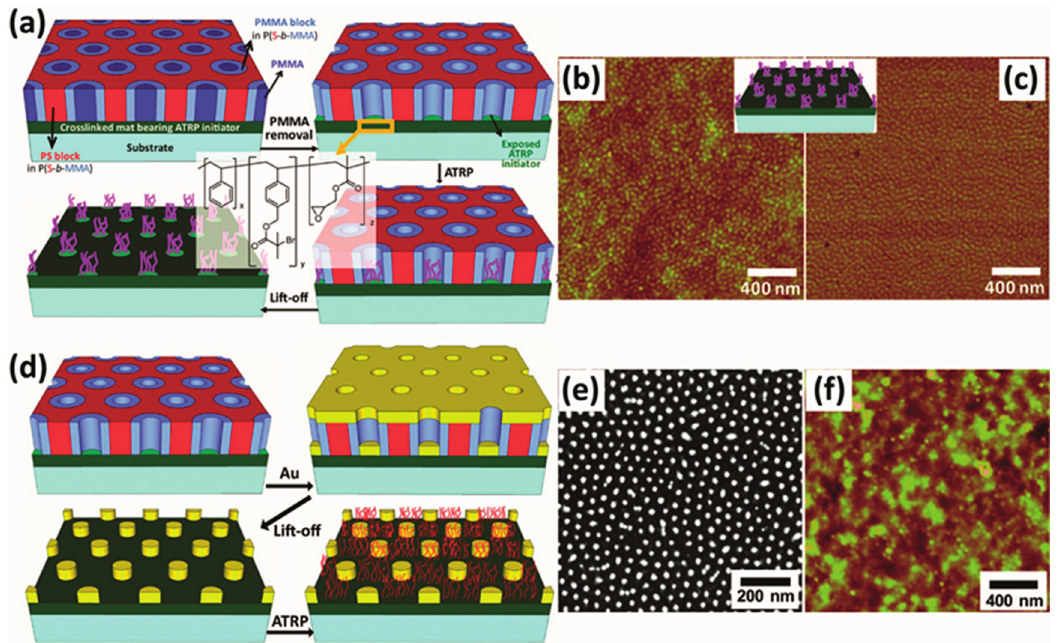
Figure 7. ( a ) The formation of a BCP template and polymer brush growth with a dual-functional initiator containing crosslinked thin film; ( b ) AFM height image of grown polymer brushes after removal of PS template; (c ) AFM phase image of polymer brush after removal of PS template; ( d ) the fabrication of Au dot arrays with subsequent brush growth; ( e ) Top-down SEM image of Au dot arrays after template lift-off; and ( f ) AFM height image after growth of PEGMEMA (Reproduced with permission from Reference [107], Copyright 2013, American Chemical